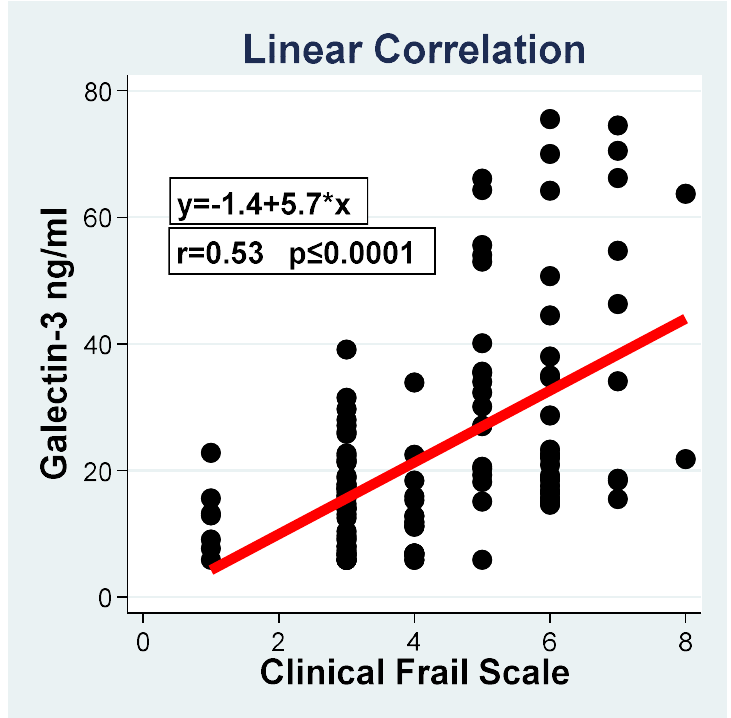
Figure 1. Linear correlation between the Galectin-3 and Clinical Frail values.